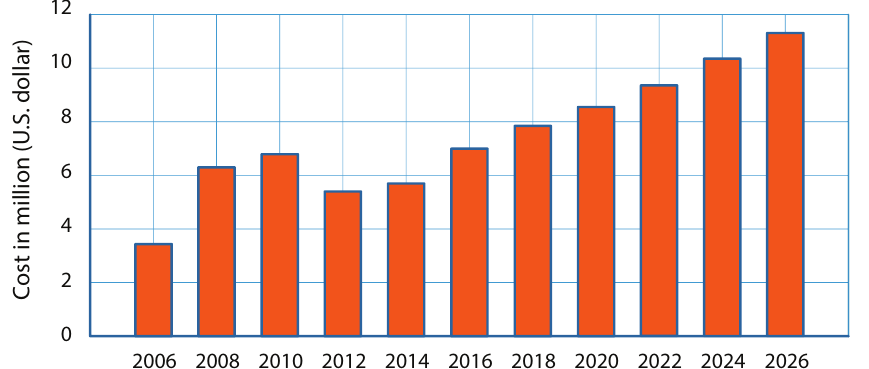
Figure 1. Total financial loss due to cyberattacks on the healthcare industry (2006–2026)